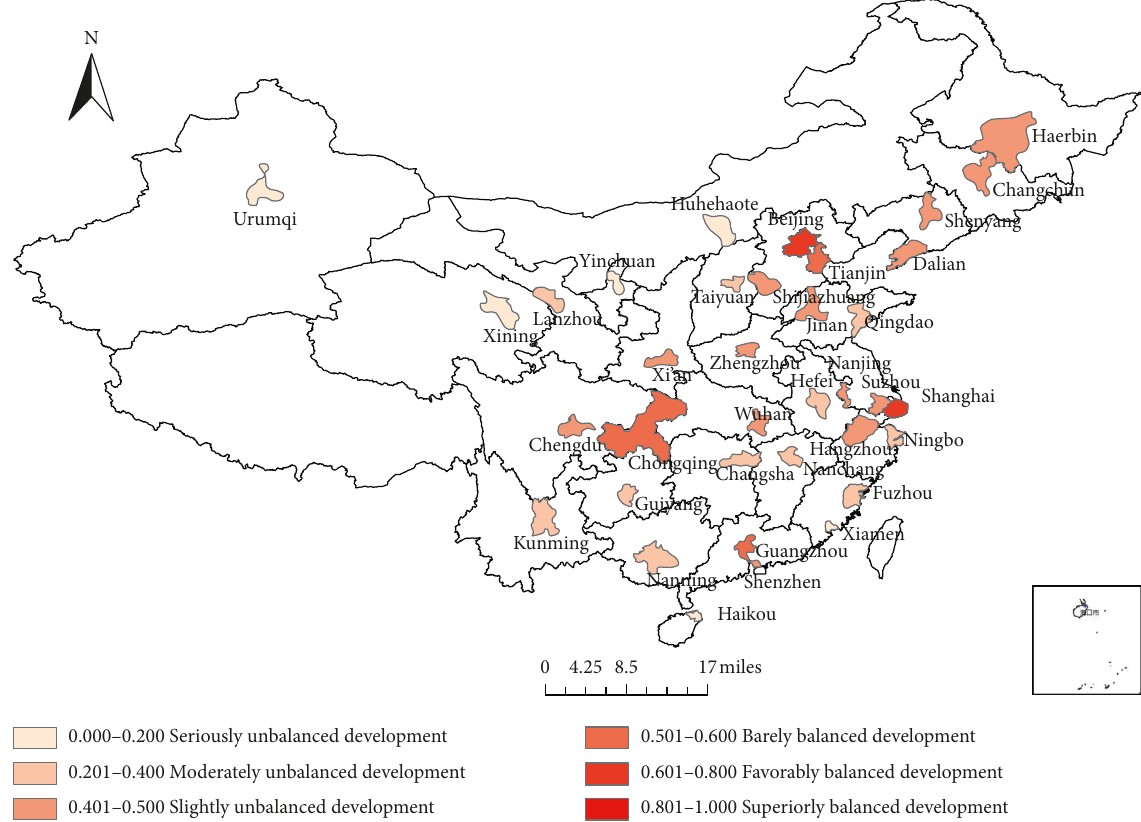
Figure 6: Spatial distribution of CCD in UPE, economy, and population in